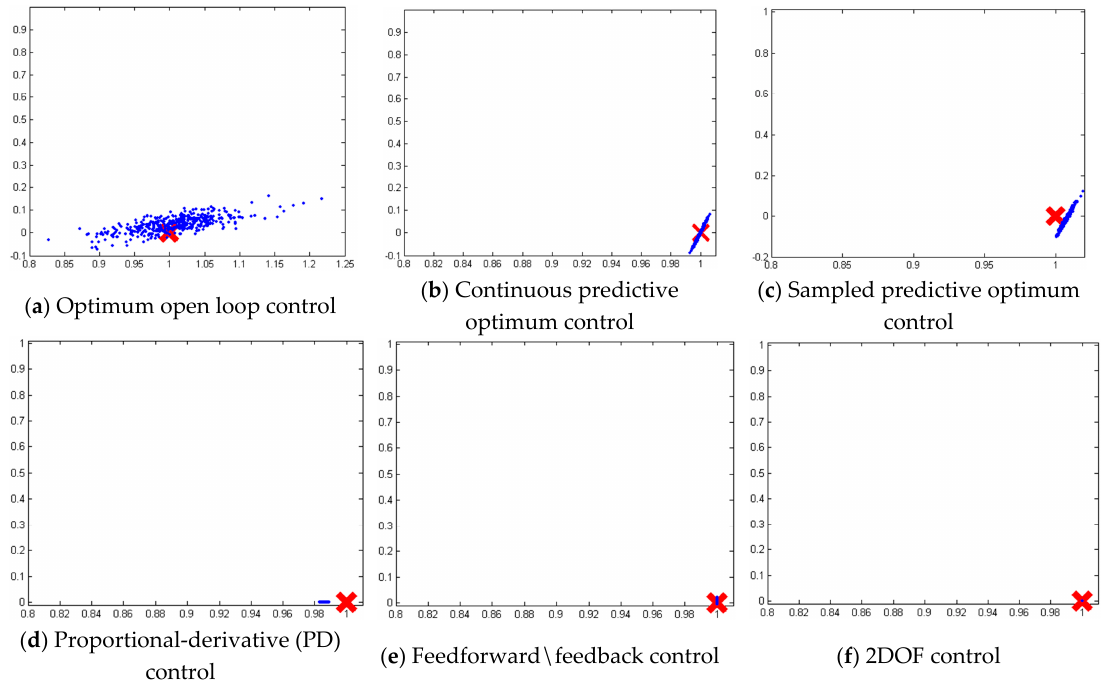
Figure 10. Monte Carlo analysis of a deterministic plan with noise with 𝜃 (radians) on the abscissa and 𝜔 (rad/s) on the ordinate.